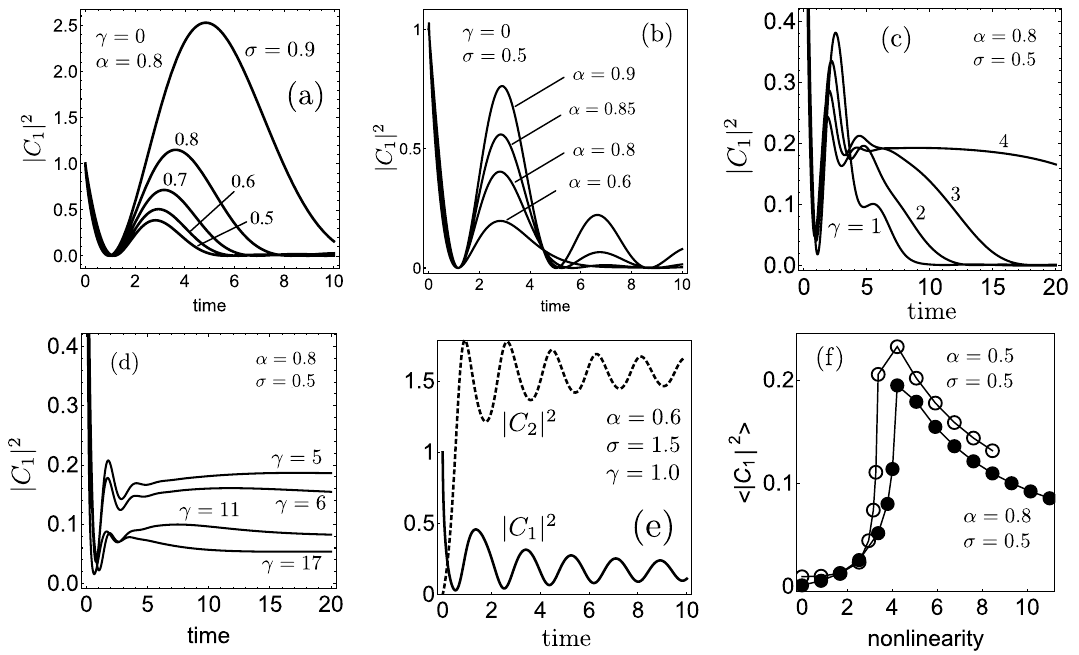
2 for the nonlinear PT case for several fractional derivative φ 1 ( z ) | |